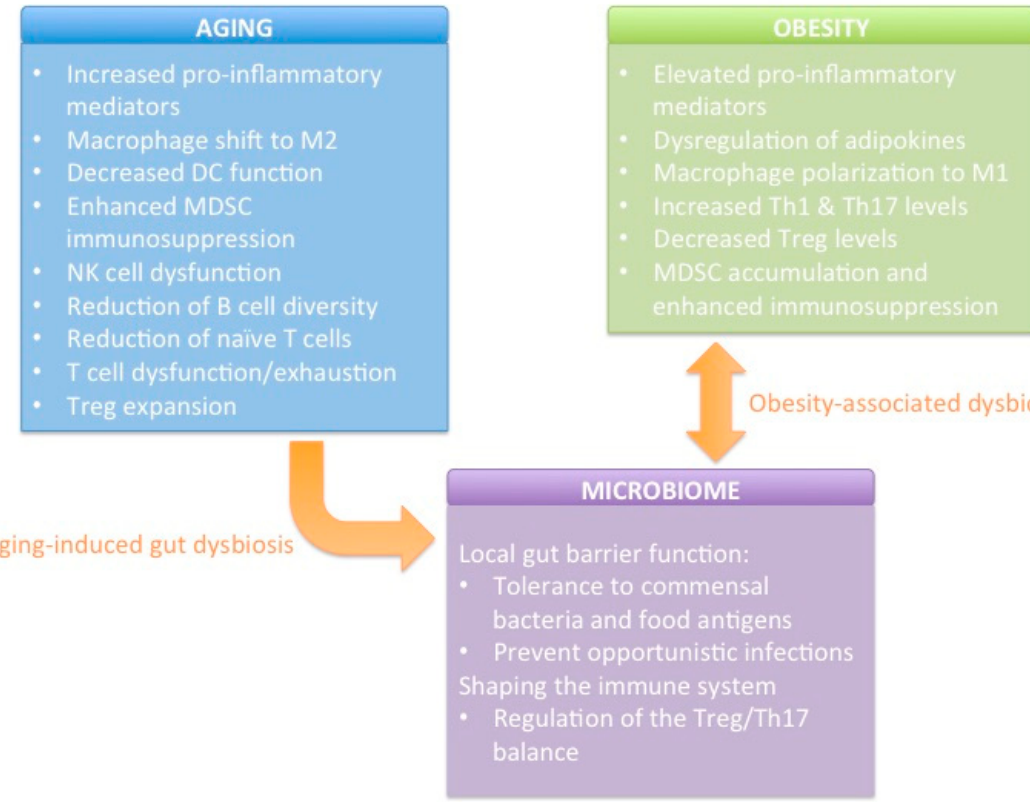
Figure 1. The immunological effects of aging, obesity, and the microbiota. DC: dendritic cell; MDSC: myeloid-derived suppressor cell; NK: natural killer cell; Treg: regulatory T cell; Th: T helper cell. The immunosenescence-associated decline in naïve T cells might be important for neoantigens (from genomic alterations or viral infection) that are “new” for the immune system and to which no